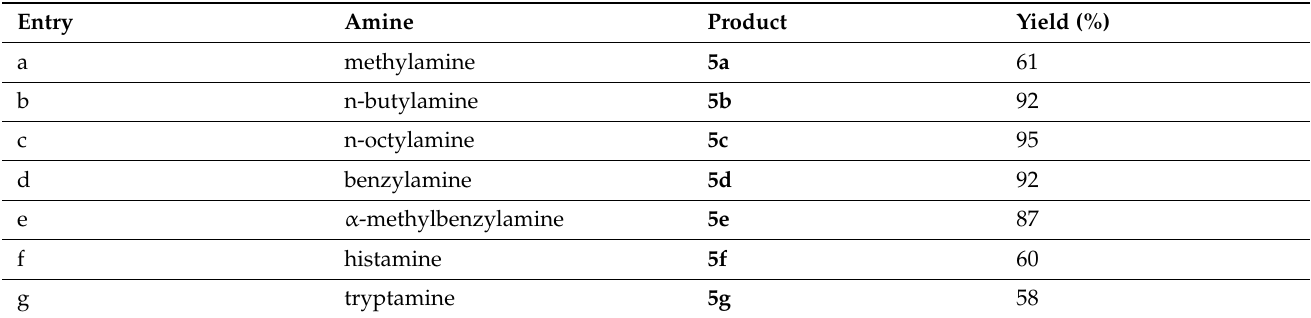
Table 1. Synthesis of Ricinine ( 5a ) and N-analogues of Ricinine ( 5b – g